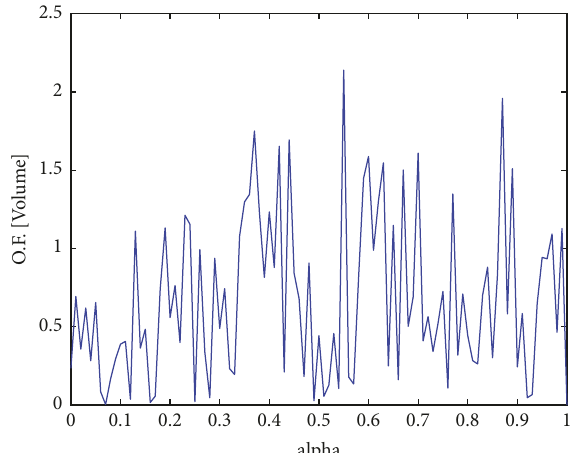
Figure 4: OF1 scan for DTA-DNL between the seed matrix (alpha = 0) and the true matrix (alpha = 1).